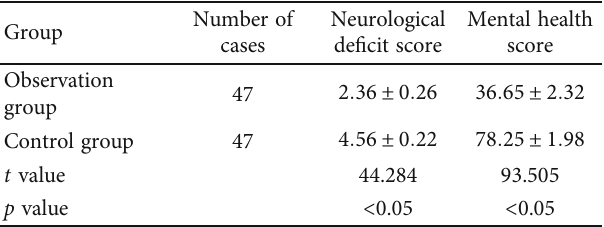
Table 2: Comparison of neurological de fi cit score and mental health score between the two groups ( x ± s